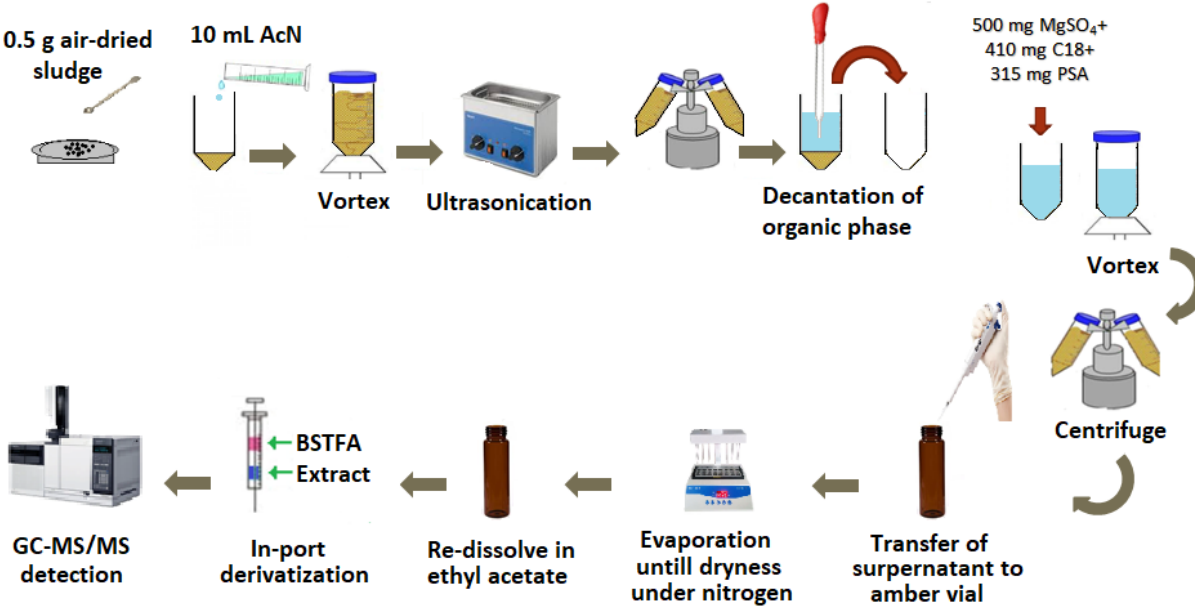
Figure 1. Schematic illustration of the whole procedure.